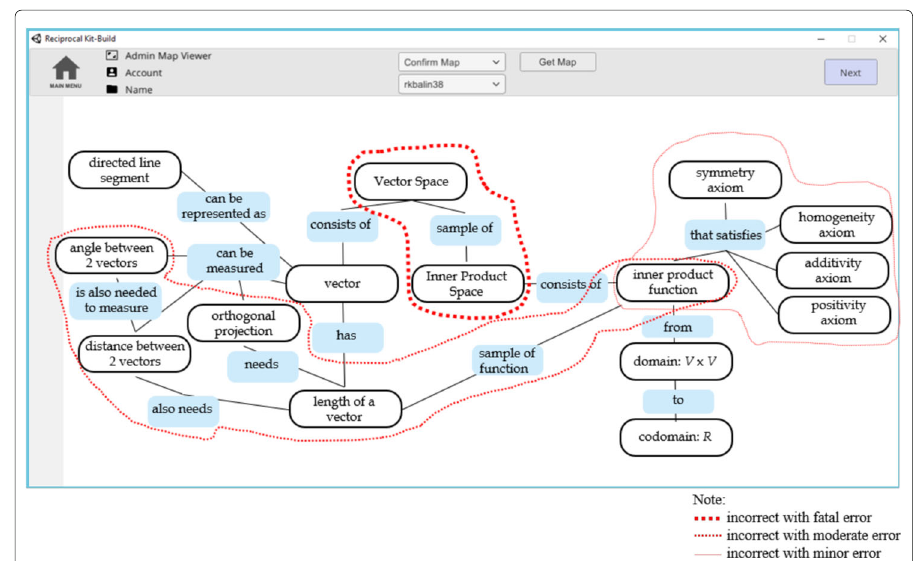
Fig. 8 Sample of a low-quality collaborative map with the score of 75.71. Some sub-substructures were written incorrectly. The group is belong to high-prior-knowledge-equivalence and low-shared-knowledge condition